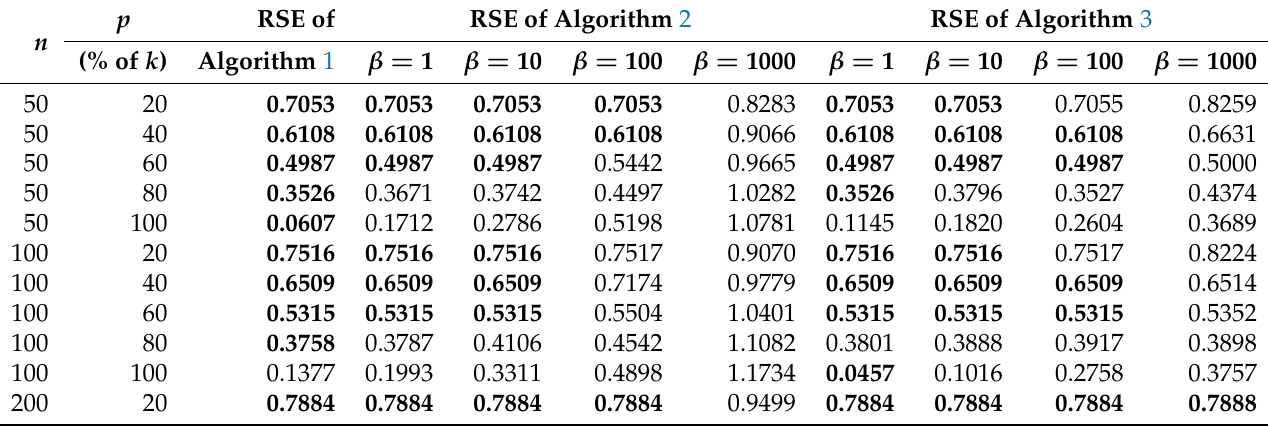
Table 4. RSE obtained by Algorithms 1–3 on the BION data. For the latter two algorithms, we used α = β ∈ { 1,10,100,1000 } . For each n ∈ { 50,100,200,500,1000 } we take all ten matrices R (five of them corresponding to k = 0.2 n and five to k = 0.4 n ). We run all three algorithms on these matrices with inner dimensions p ∈ { 0.2 k ,0.4 k , . . . ,1.0 k } with all possible values of α = β . Like before, each row represents the average (arithmetic mean value) of RSE obtained on instances corresponding to given n and given p as a percentage of k . We can see that the larger the β , the worse the RSE, which is consistent with expectations. The bold number is the smallest one in each